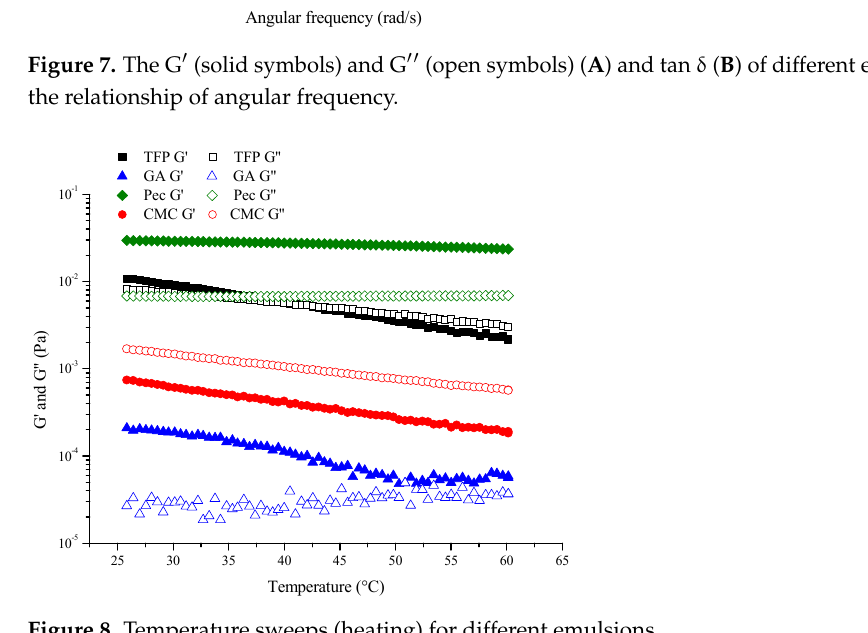
Figure 8. Temperature sweeps (heating) for different emulsions.